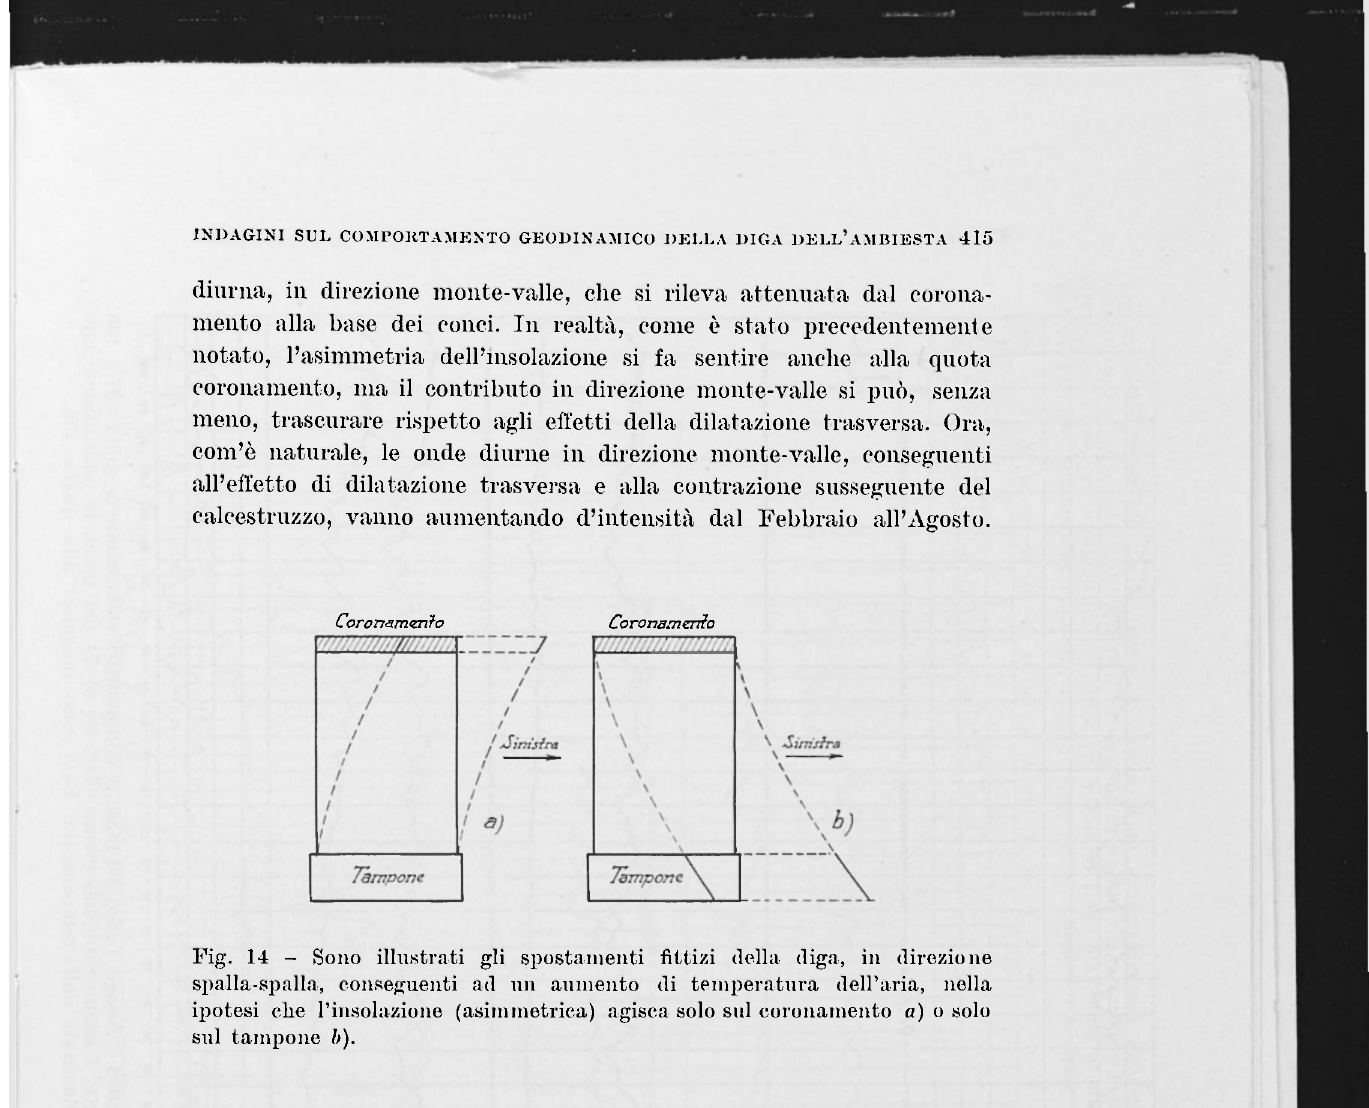
Fig. 14 - Sono illustrati gli spostamenti fittizi della diga, in direzione spalla-spalla, conseguenti ad un aumento di temperatura dell'aria,